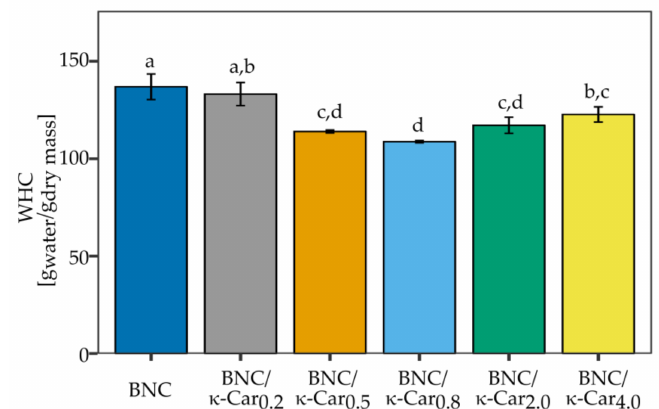
Figure 5. Water holding capacity of BNC and BNC/ κ -Car composites (The data are presented as the means ± SD from at least three independent experiments; the means that are marked with different letters are significantly